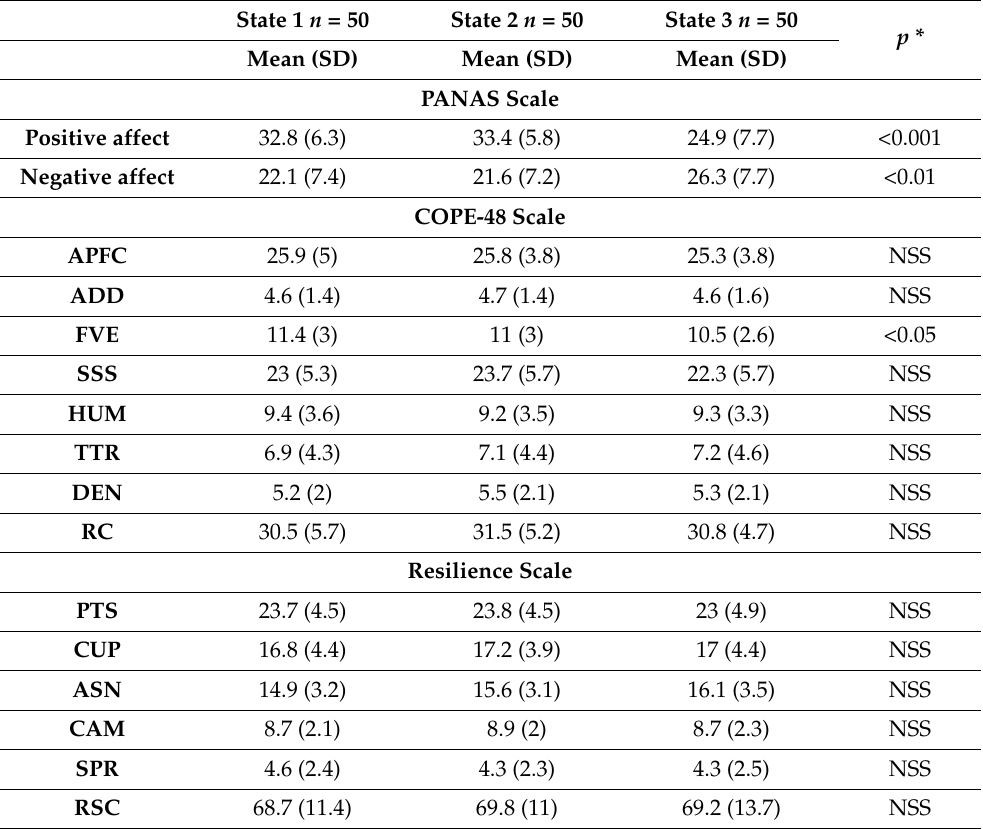
Table 3. Results of the PANAS, COPE-48, and Connor–Davidson Resilience scales according to study